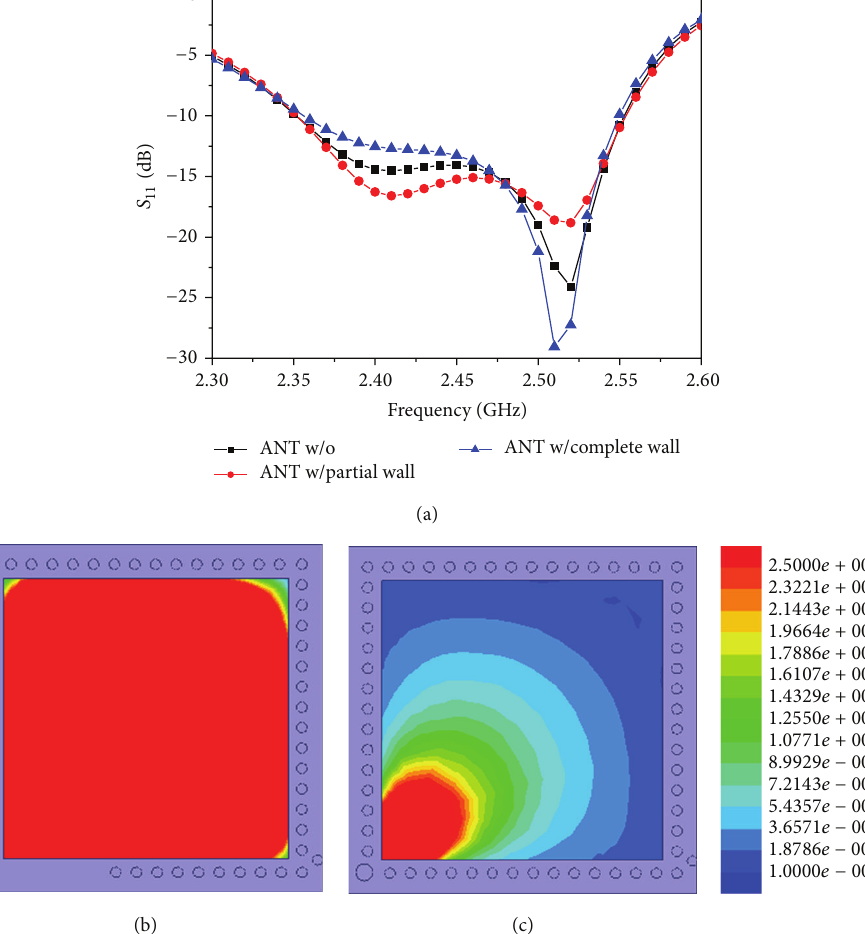
Figure6: Effect ofthenumberof viason thepackaged-chip and theproposedintegrated antenna, (a) 𝑆 11 inthreecases, (b) E -field distribution in the cavity with partial wall, and (c) E -field distribution in the cavity with complete